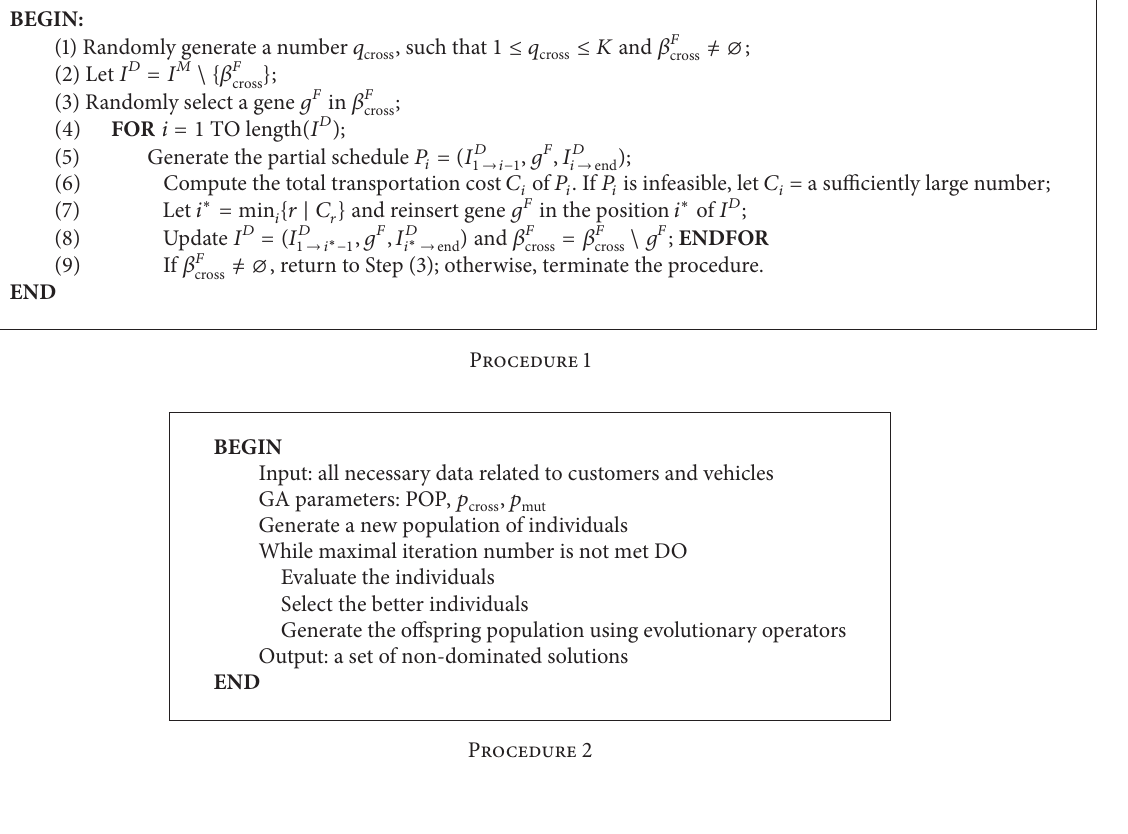
Table 1: The situation of vehicles in the logistics enterprise S. Vehicle model